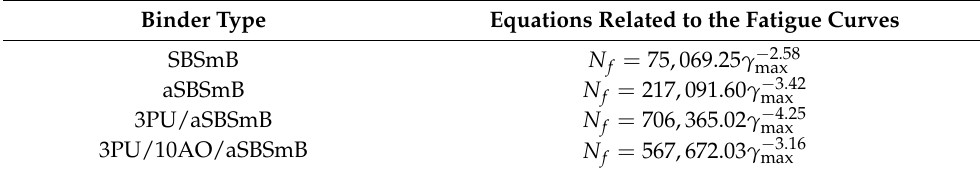
Figure 6. Fatigue life prediction for the virgin, aged, and rejuvenated SBSmB. Table 4. Fatigue life comparison of target